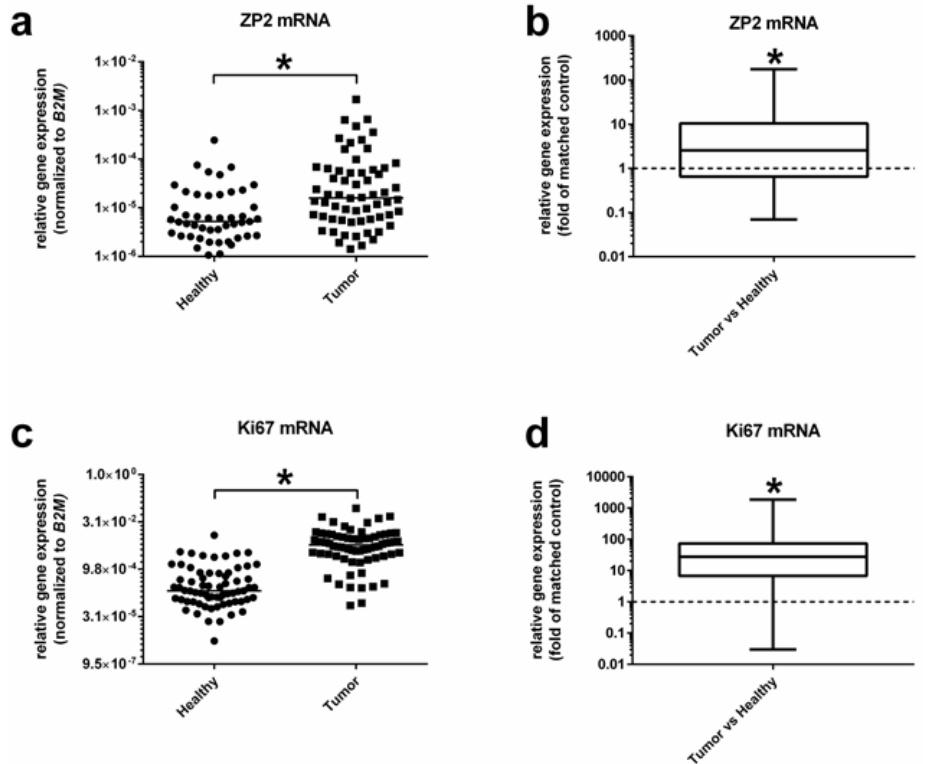
Figure 2. Expression levels of ZP2 and Ki67 in healthy and tumor tissue samples. ( a ) Relative gene expression of ZP2 compared to the housekeeping gene B2M. ZP2 is significantly more highly expressed in tumor cells. ( b ) Differential relative expression of ZP2 compared to matched controls. ( c ) Relative gene expression of Ki67 compared to the housekeeping gene B2M. Ki67 also shows a significantly increased expression in tumor cells. ( d ) Differential relative expression of Ki67 compared to matched controls. Significant differences are depicted with asterisks (* for p < 0.05).